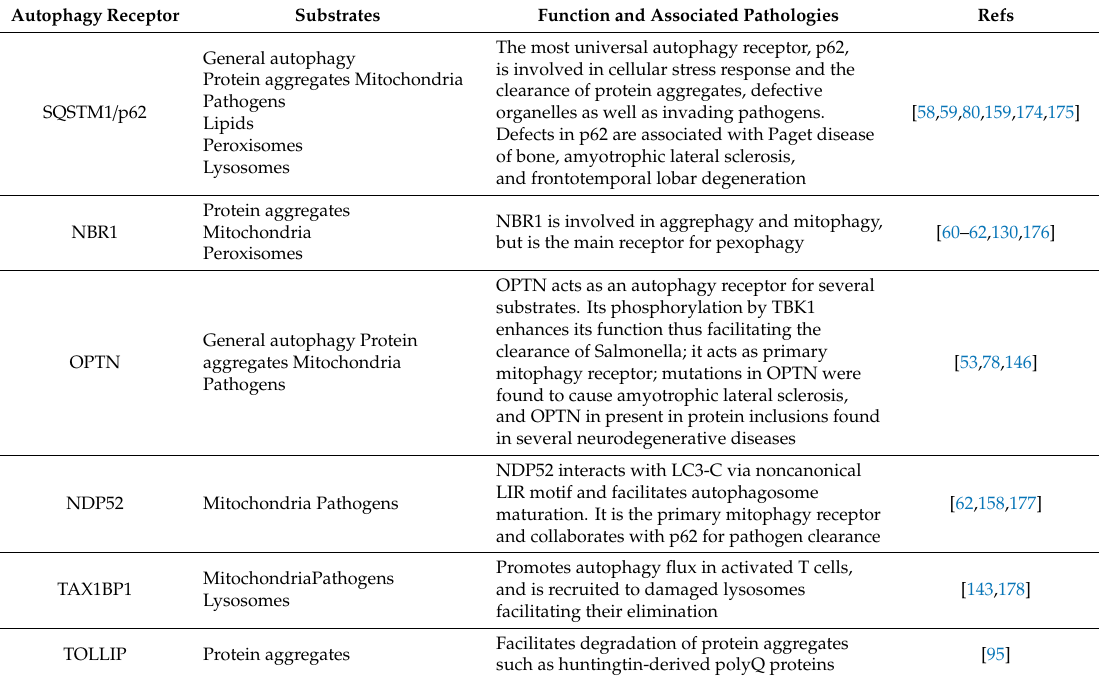
Table 1. Ubiquitin dependent autophagy receptors and their